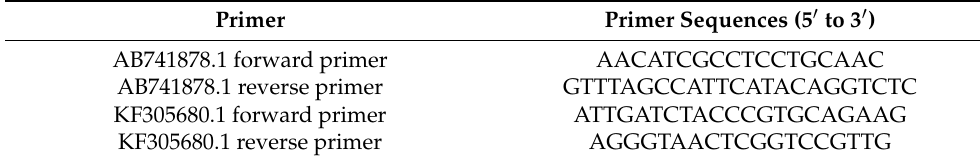
Table A2. The primers detected by real-time